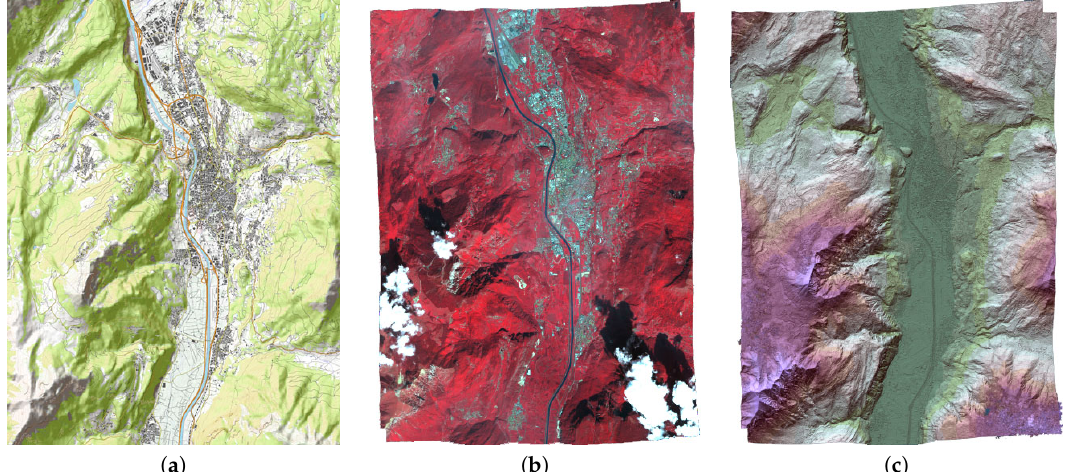
Figure 4. The test site Trento (Italy): ( a ) topographic map (opentopomap.org (CC-BY-SA)), ( b ) CIR ortho-image and ( c ) relief shaded DSM. ( b , c ) were produced employing the proposed and implemented mapping